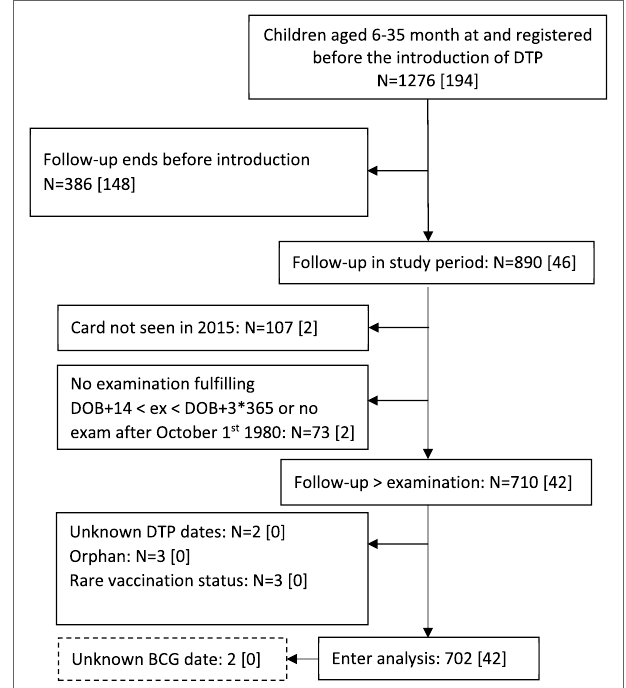
FigUre 1 | Flowchart of study population and children included in the analyses. DOB, date of birth; [], died during follow-up. Children were only included in the main analysis if they had taken part in a weighing session after October 1,